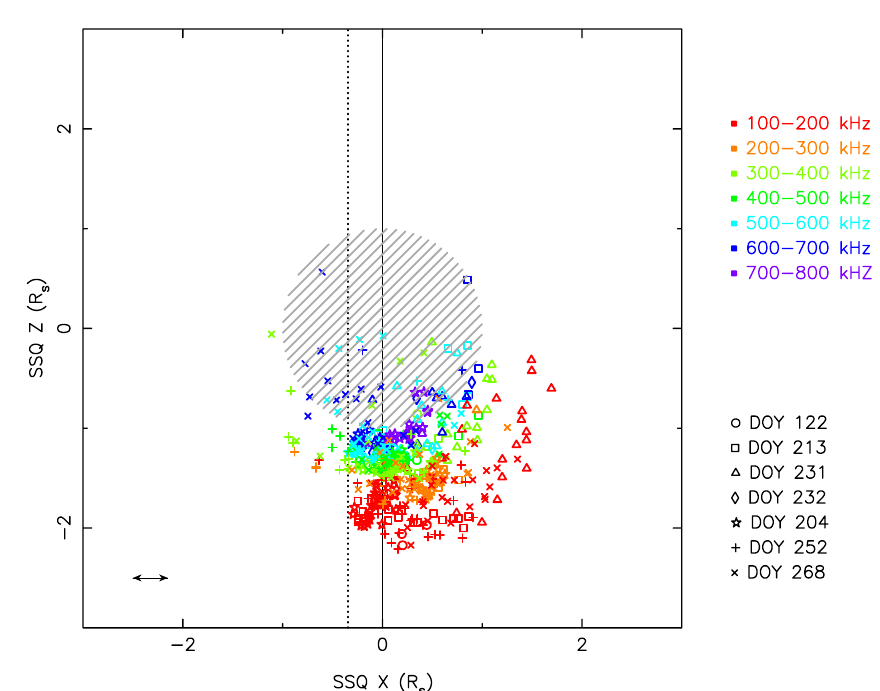
Fig. 5a. Results of direction finding in the SSQ x-z plane for time periods with criterion 4 removed, thus expanding the days to include passes on days 122, 213, 231, and 232 of 2005.